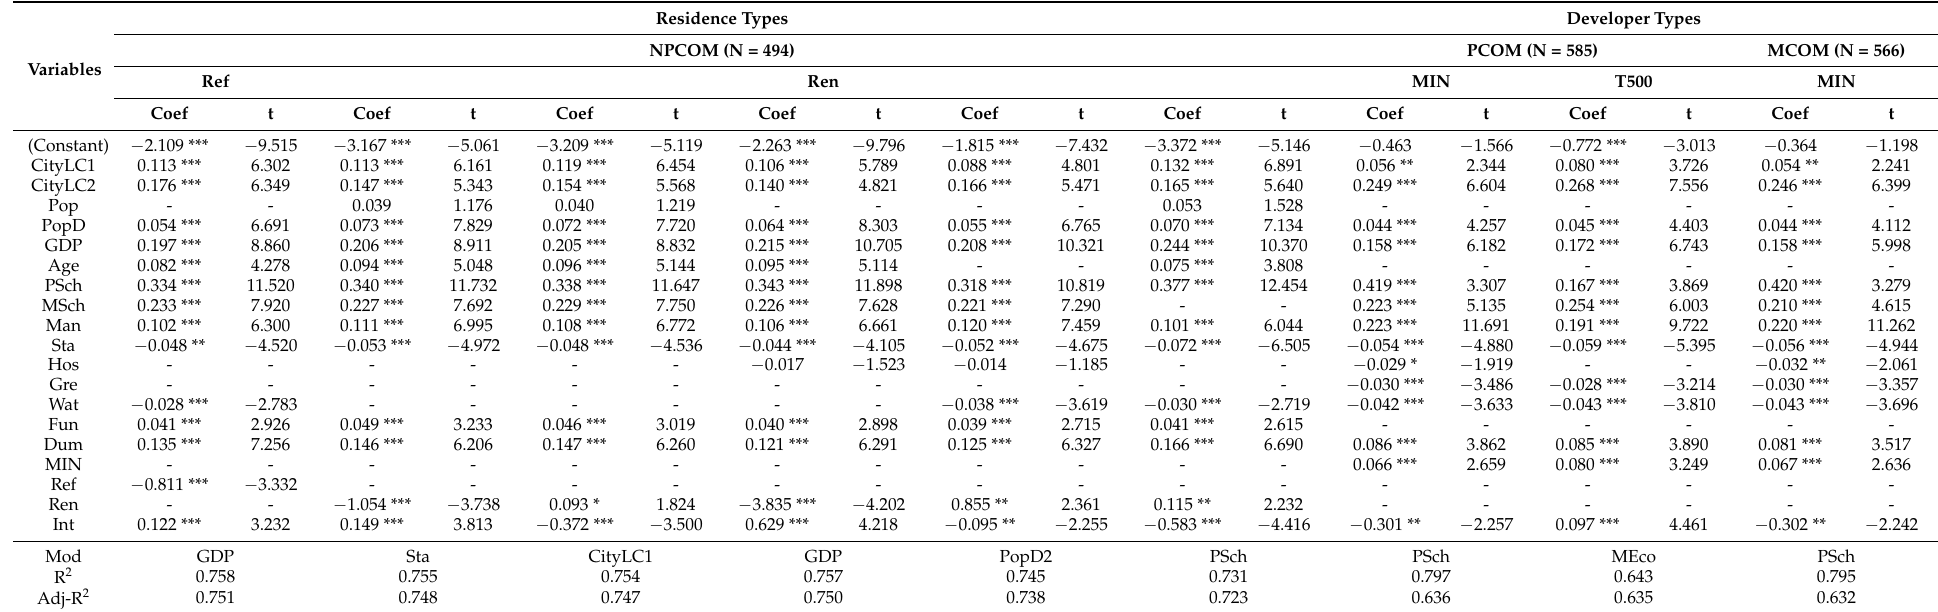
Table 11. Robust test results of interactive